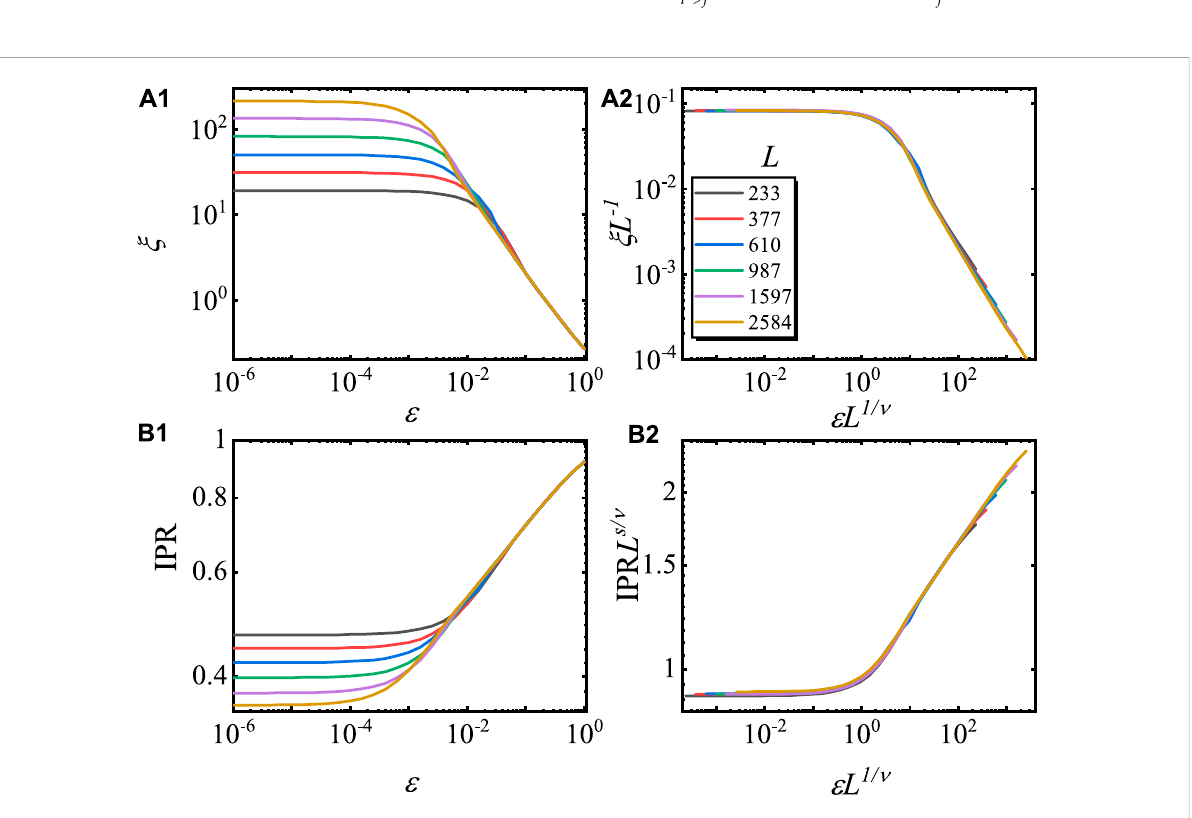
FIGURE 3 Finitescalingof ξ andIPRofthegroundstateinthelocalizedphase.Thecurvesof ξ versus ε before(A1)andafter (A2)rescaling,accordingtoEq. 5 for different L values. The curvesof the IPR versus ε before (B1) and after (B2) rescaling, according to Eq. 8 for different L values. Here, g = 0.5, ε > 0, and the model is in the localized phase region. Double-log scales are used, and the results are averaged for 100 choices of ϕ